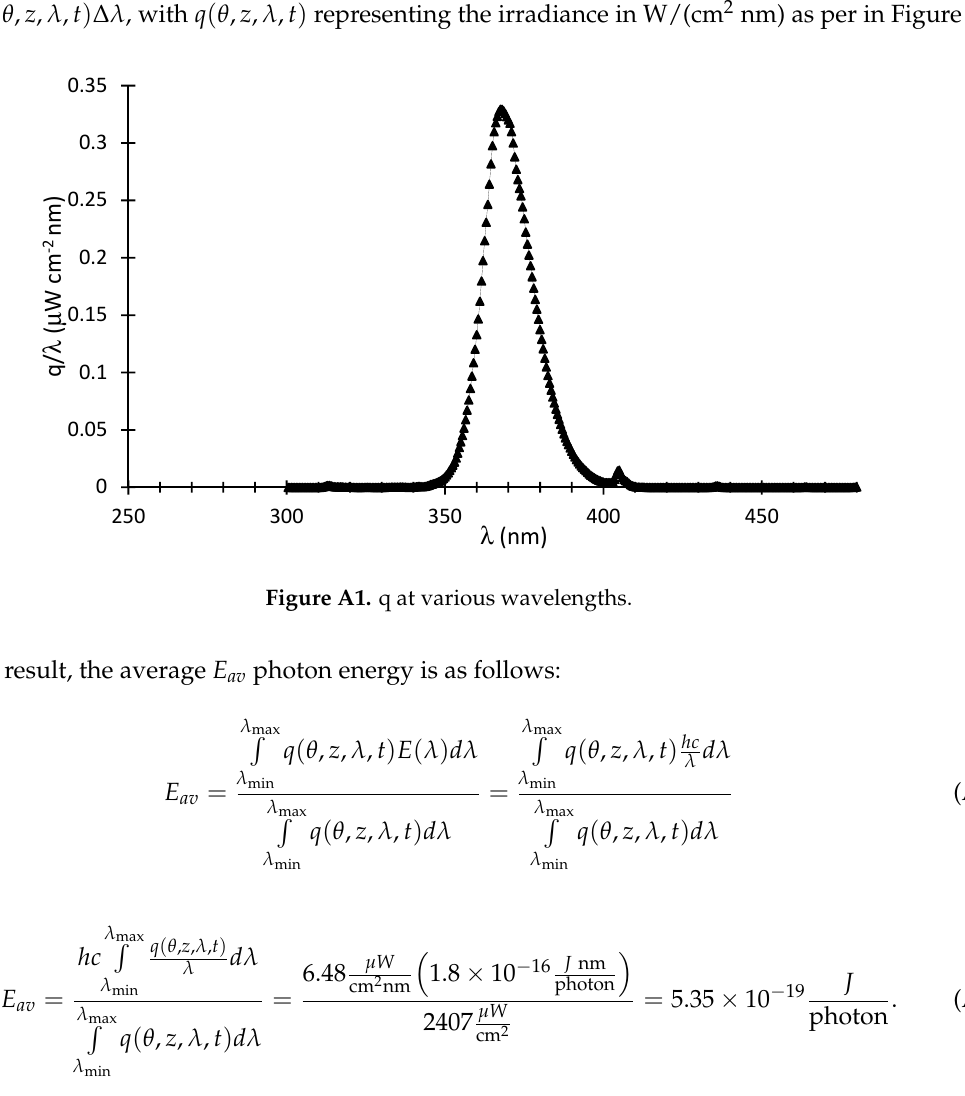
representing the irradiance in W/(cm 2 nm) as per in